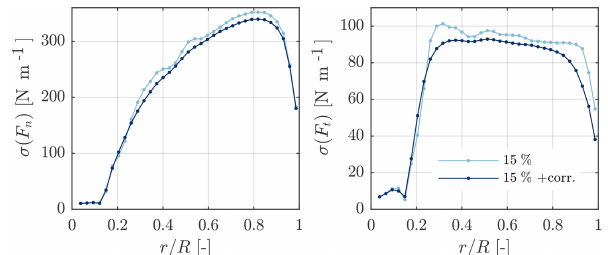
Figure 16. Variation of normal and tangential forces on the NREL 5-MW blades at an 8ms − 1 mean wind speed and turbulence inten- sity of 15% predicted by the AL model with and without smearing correction ( N s = 35, (cid:15) = R/